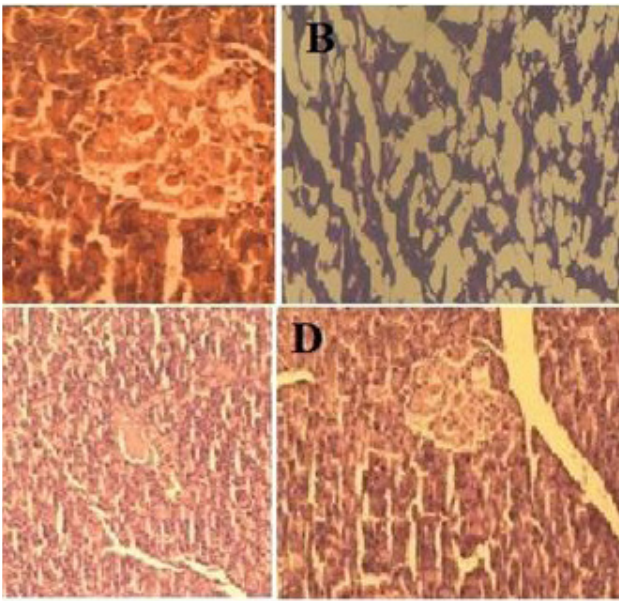
FIGURE 6 - Histology of pancreas of experimental rats after treatment with TAY , 500 mg/kg . (A) Normal control, (B) Diabetic control, (C) Diabetic treated with TAY (500 mg/kg), (D) Diabetic treated with